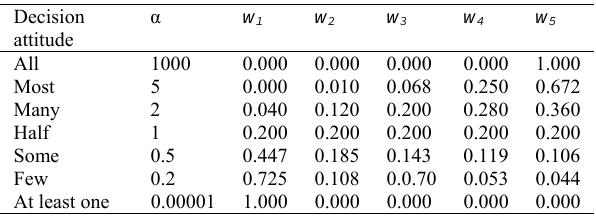
Table 10. The weights under the common decision attitudes.